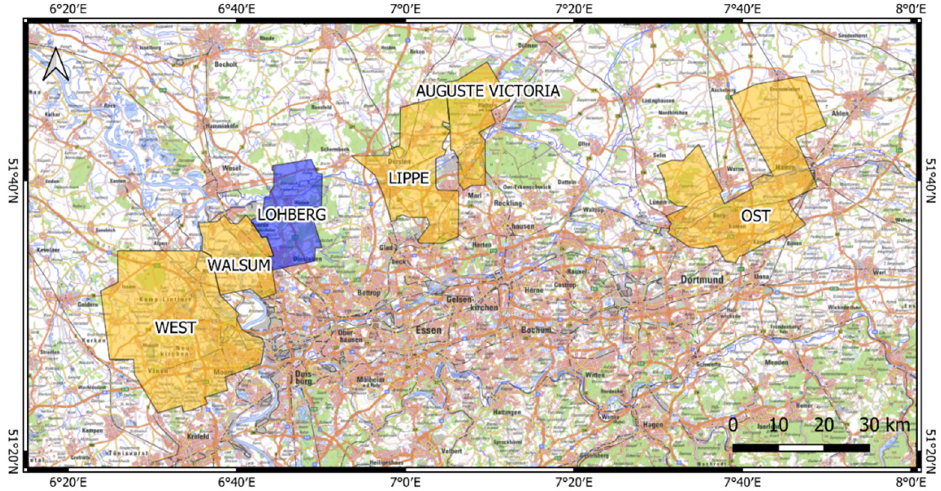
Figure 3. Map with marked regions under analysis in order to estimate residual subsidence and their duration. their